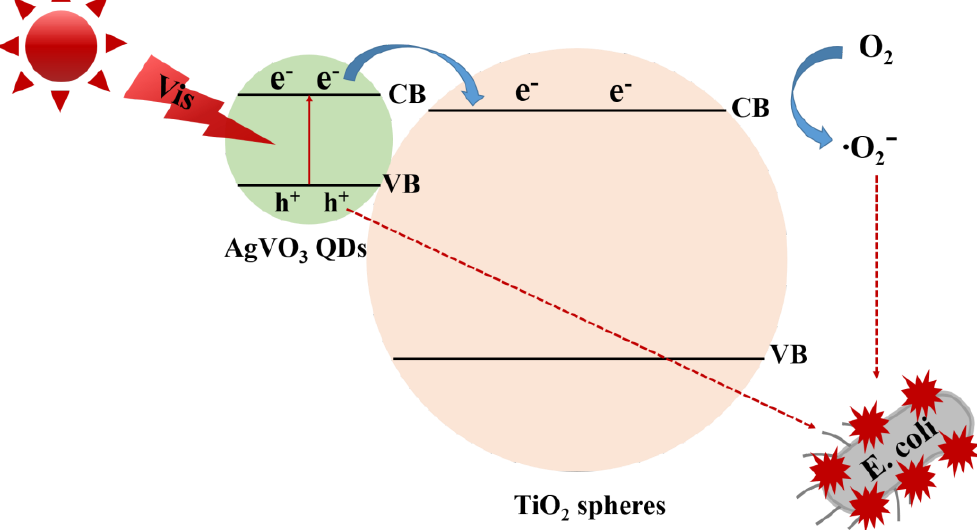
Figure 2. Antibacterial mechanism of TiO 2 /AgVO 3 nanocomposites with visible light illumination. Reproduced with permission from ref. [75]. Copyright © 2019, Elsevier.